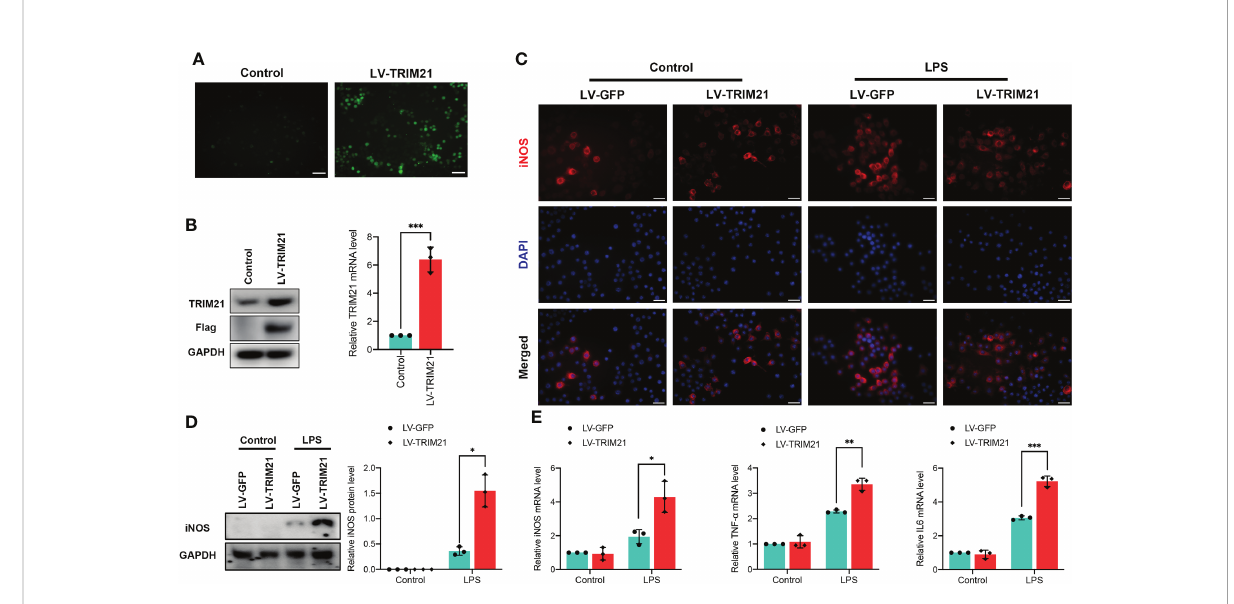
FIGURE 5 TRIM21 overexpression induces macrophage polarized into M1 phenotype in RAW264.7 cells. (A) Representative images of RAW264.7 cells transfected with lentivirus targeting the TRIM21 gene (LV-TRIM21) or negative lentivirus (LV-GFP). The protein levels of TRIM21 and Flag (A) and the mRNA of TRIM21 (B) in RAW264.7 cells. (C) Representative images of iNOS staining in LPS-stimulated RAW264.7 cells transfected with LV- TRIM21 or LV-GFP. Scale bar: 200 mm. (D) The protein level of iNOS and mRNA levels of iNOS, IL-6 and TNF- a (E) in LPS-stimulated RAW264.7 cells transfected with LV-TRIM21 or LV-GFP. For (A-E) , data are representative of 3 independent experiments. n = 3 sets of cells/group. *P<0.05, **P<0.01, and